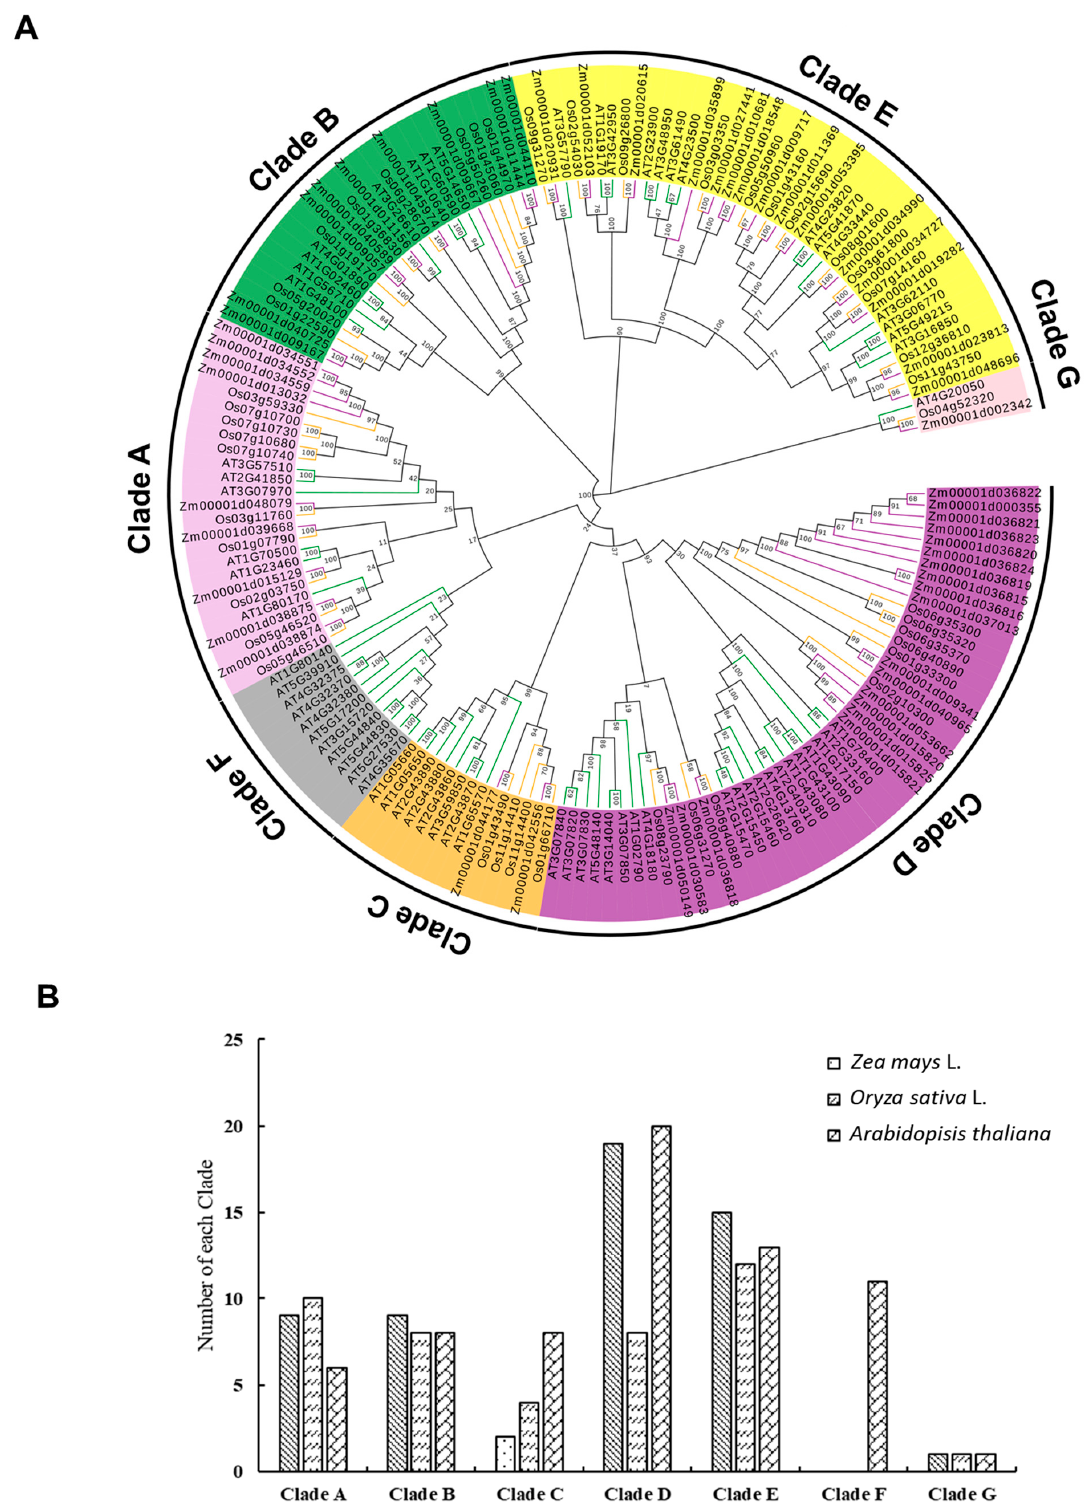
Figure 1. Phylogenetic analysis of PG genes from Arabidopsis thaliana , rice, and maize. ( A ) An unrooted phylogenetic tree was constructed by using full-length protein sequences. The different color shades are used to distinguish different branches, and Clades A–G indicate the PG gene family classifications. ( B ) PG gene numbers of each Clade in Arabidopsis thaliana , rice, and maize.